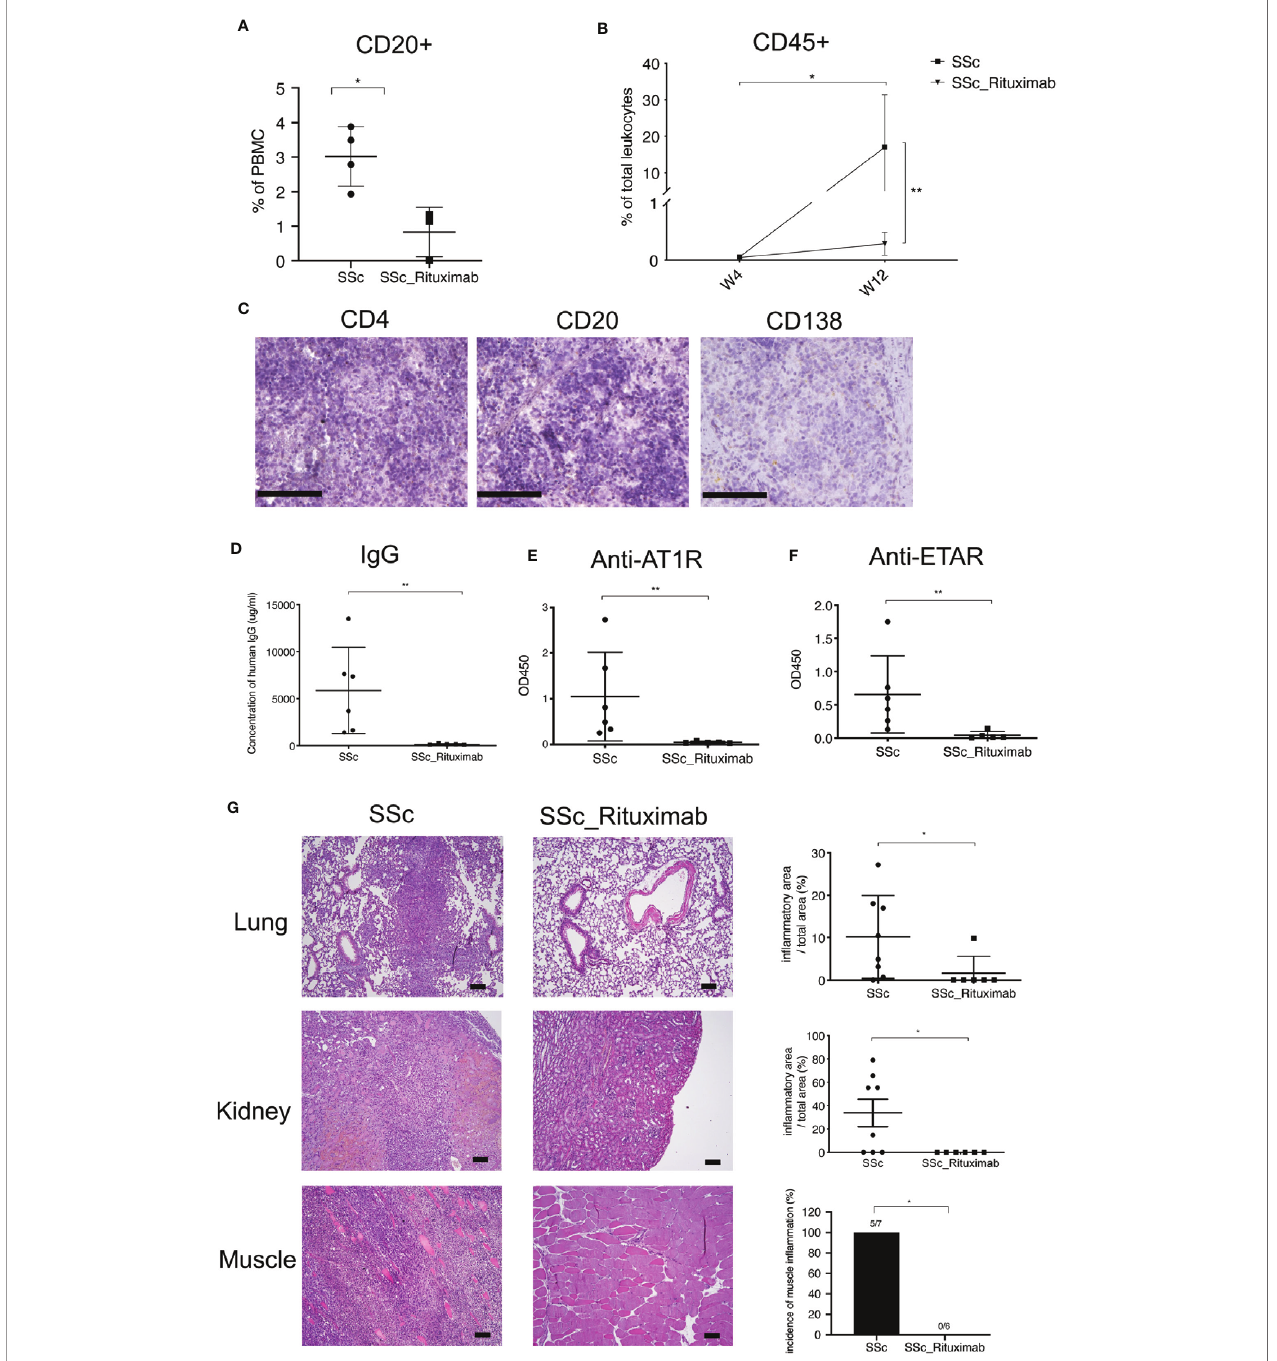
FIGURE 5 | PBMC derived from Rituximab-treated SSc patients do not induce disease symptoms in mice. (A) Relative amounts of CD20 + cells in PBMC derived from untreated and Rituximab-treated SSc patients. Percentages of CD20 + cells in PBMC were detected by FACS after the PBMC isolation from blood samples of SSc patients (SSc) and SSc patients treated with Rituximab (SSc_Rituximab). (B) Relative amounts of human leukocytes in peripheral blood of recipient mice. (C) Representative micrographs of immunohistochemistry stainings of human CD4 + T cells, CD20 + B cells and CD138 + cells (bar = 100 µm) of spleens of mice receiving PBMC from SSc patients treated with Rituximab. (D) Production of total human IgG in sera of recipient mice. Levels of human IgG autoantibodies against AT1R (E) and ETAR (F) were determined in sera of recipient mice. (G) In fl ammation of lung, kidney and muscle of recipient mice. Representative histologic images are shown (bar = 100µm) in the left panel, while the right panel shows the quantitative scores of in fl ammation evaluated in a blinded manner based on the ratio of in fi ltrated areas to total areas of the organ. All data are presented as mean ± SD. Statistical analyses were performed using ANOVA (*p < 0.05, **p <